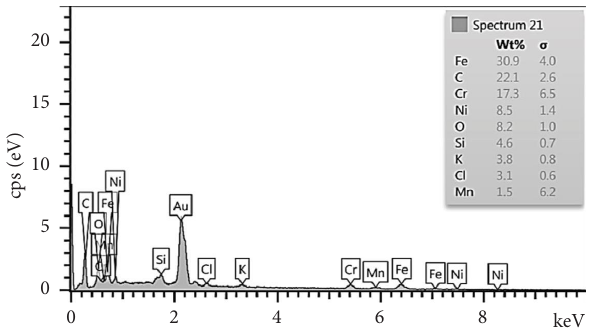
Figure 2: EDS of sample product by